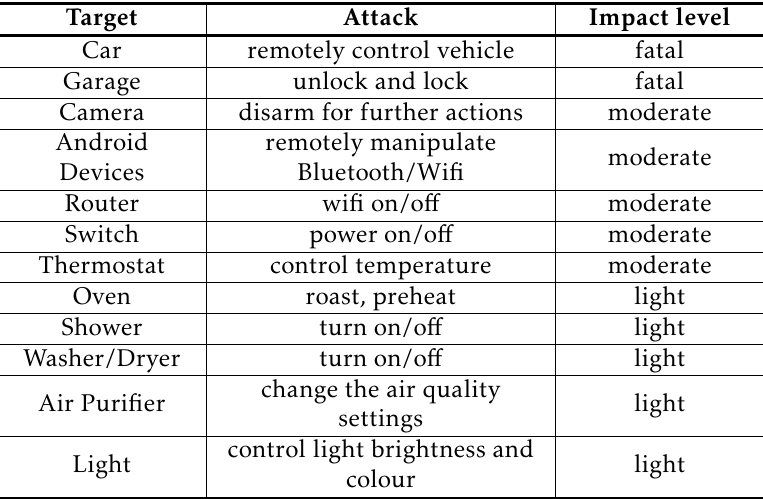
Table 4. Impact of attacking Echo in the physical